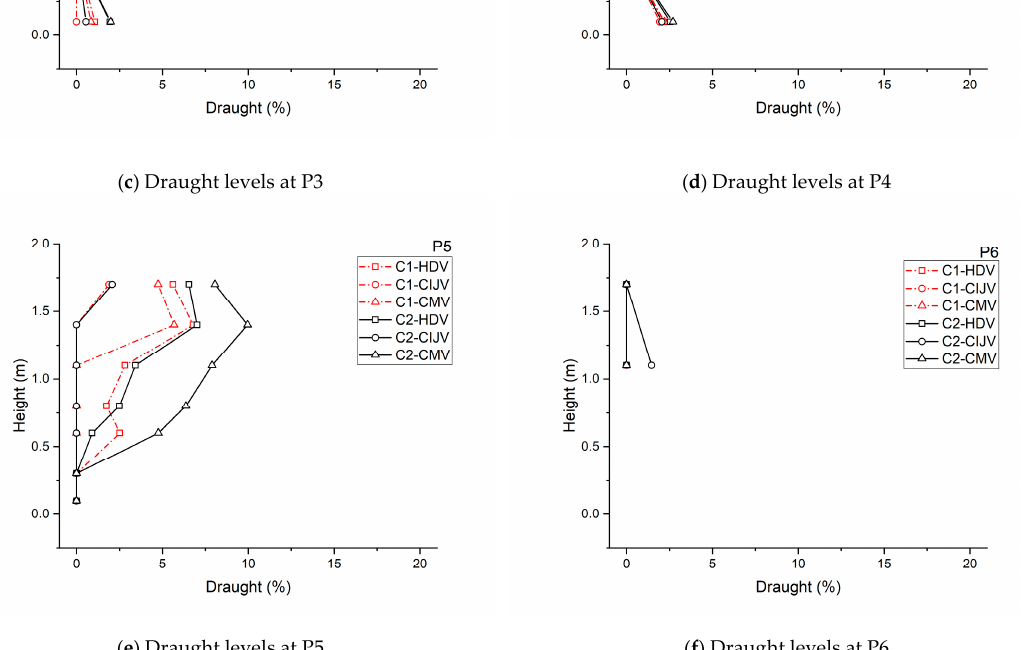
Figure 5. Draught levels at position P1 ( a ), P2 ( b ), P3 ( c ), P4 ( d ), P5 ( e ) and P6 ( f ) for all cases.